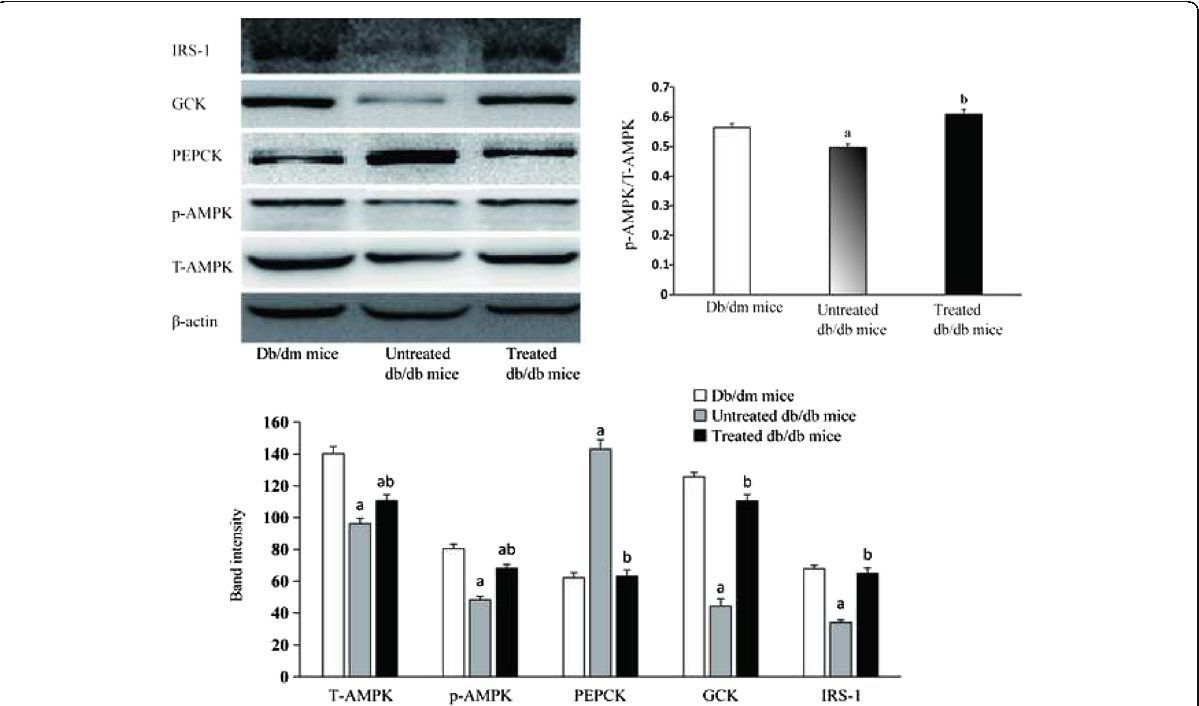
Fig. 3 Effects of esculeoside A on the proteins involved in glucose uptake pathway. Values having different superscripts are significantly different, P < 0.05, one-way ANOVA test. a. Statistical difference compared to the db/dm mice, b. Statistical difference compared to the untreated db/db